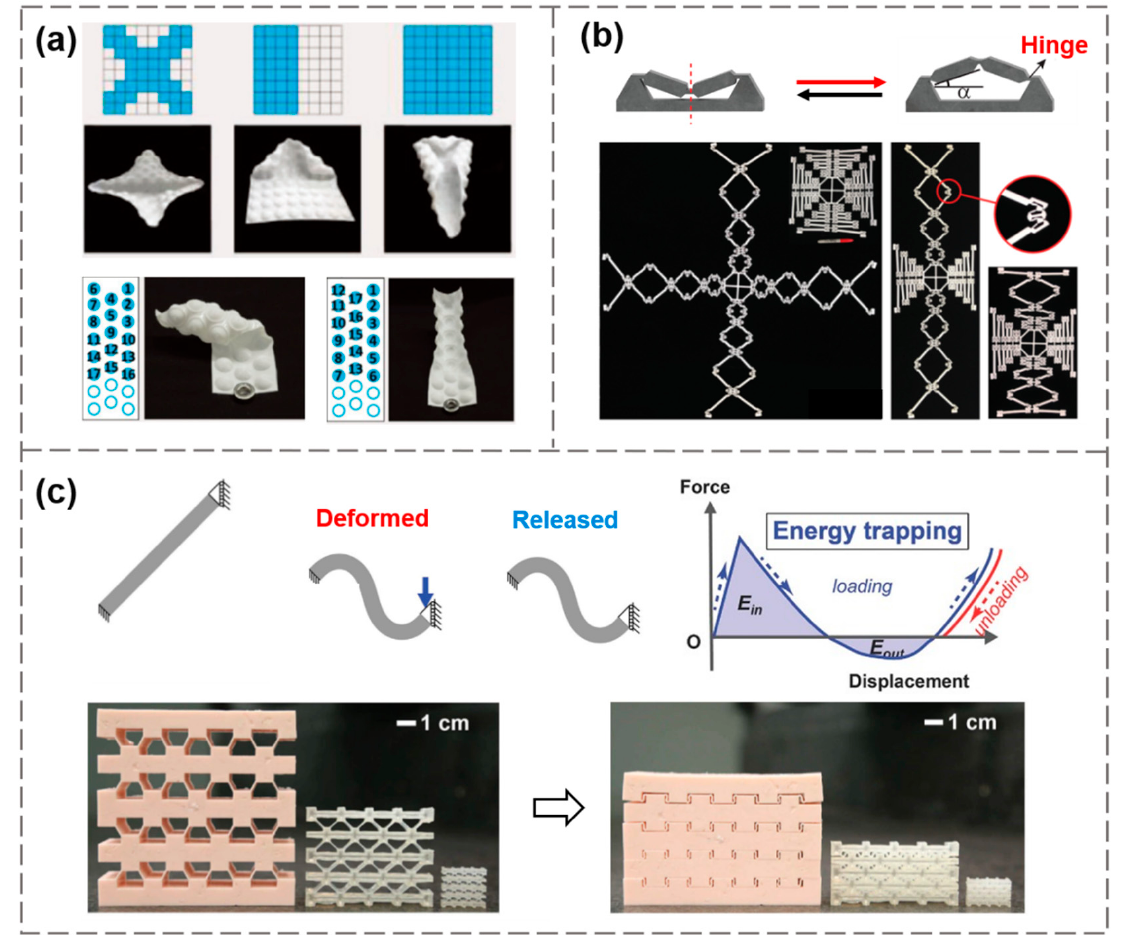
Figure 10. Using bistable building blocks to design mechanical metamaterials. ( a ) Dome-patterned shape-morphing metamaterials with digital programming. Reproduced from Ref. [63]; ( b ) A de- ployable structure consisting of serially connected bistable hinges. Reproduced from Ref. [96]; ( c ) Energy-absorbing metamaterials with architected bistable units. Reproduced from Ref. [97].